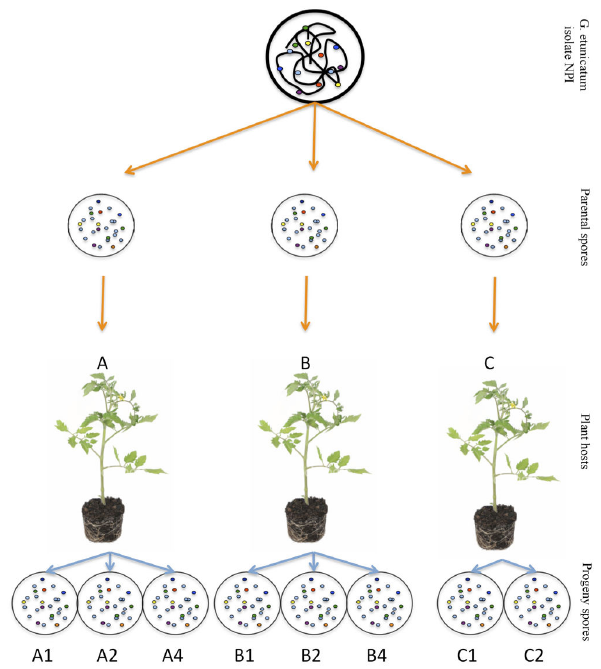
Figure 1. Diagram of the experimental setup. Three parent spores were taken from a single isolate of G. etunicatum and grown in pot culture to produce eight progeny spores for pyrosequencing. doi: